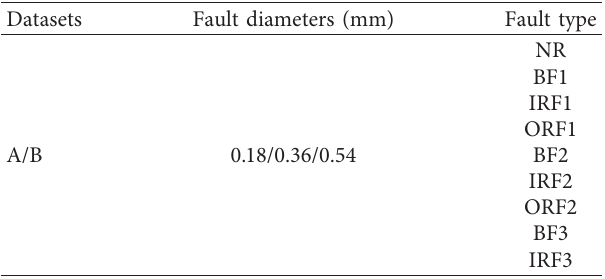
Table 1: The experiment data under various working conditions. and 0.54 mm,